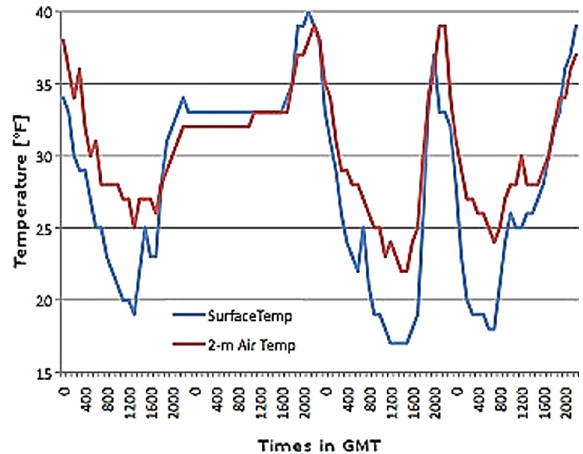
Fig. 8. A comparison of the surface and air temperatures at Marblemount,